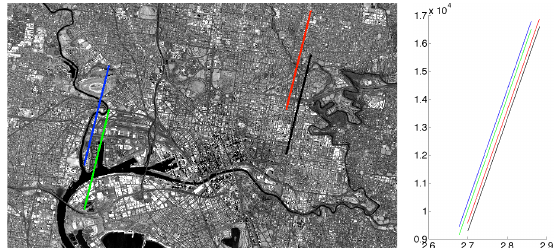
Figure 4: The RPC functions allow to draw the epipolar curves for a pair of images u and v (approx. 16000 × 40000 pixels). The left image shows four epipolar curves plotted in the domain of im- age v , they correspond to four points located near the edges of the image u . The range of altitudes considered is h ∈ [ − 200 , 3000] meters. The right image shows the same epipolar curves placed closer to facilitate the comparison.